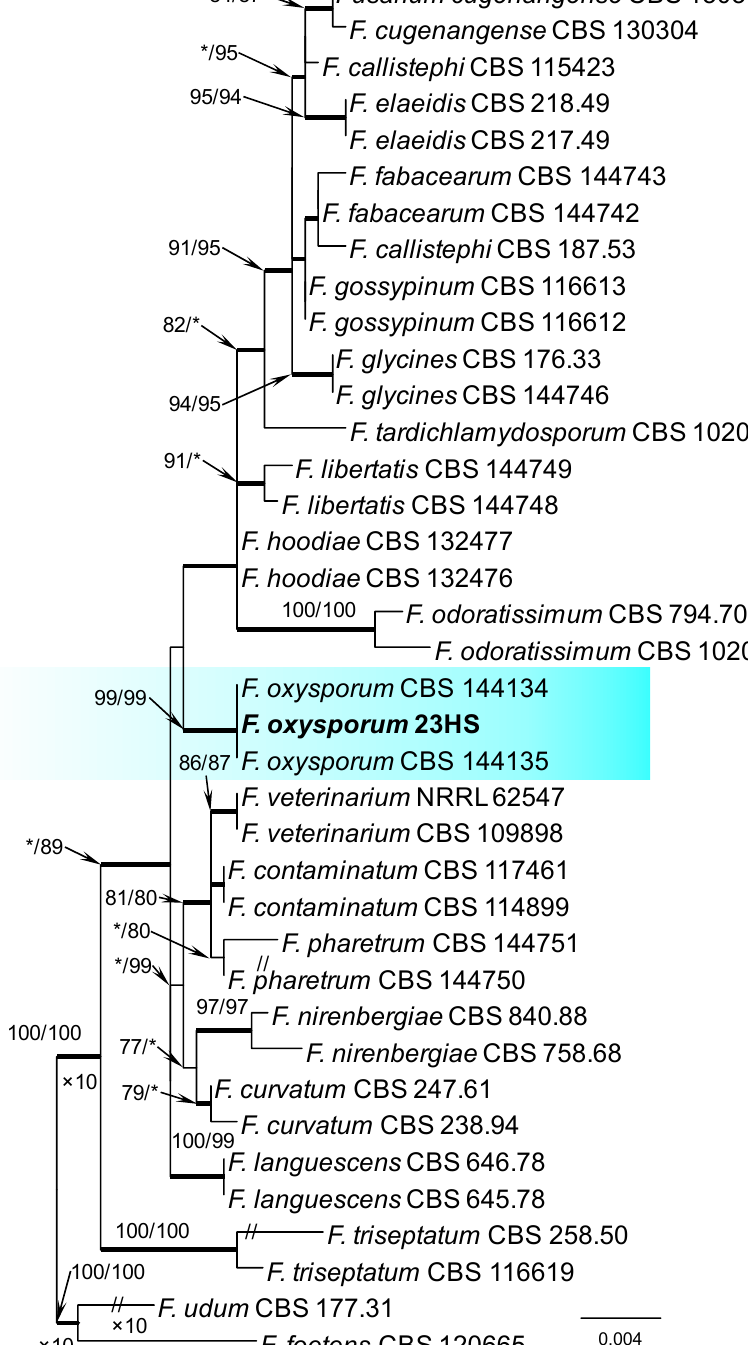
Figure 2. Phylogram obtained from Maximum Likelihood (ML) analysis of the combined dataset of RPB2 + TEF1- α for selected species of the Fusarium oxysporum SC. Sequence obtained during this study is presented in bold font. The Bootstrap values ≥ 75% for ML and Maximum Parsimony (MP) analyses are presented at nodes as follows: ML/MP. Bold branches indicate posterior probabilities values ≥ 0.95 obtained from Bayesian Inference (BI) analyses. * Bootstrap values < 75%. The tree is drawn to scale (see bar) with branch length measured in the number of substitutions per site. Fusarium foetens and Fusarium udum represent the outgroup in analyses of the combined dataset of RPB2 + TEF1- α